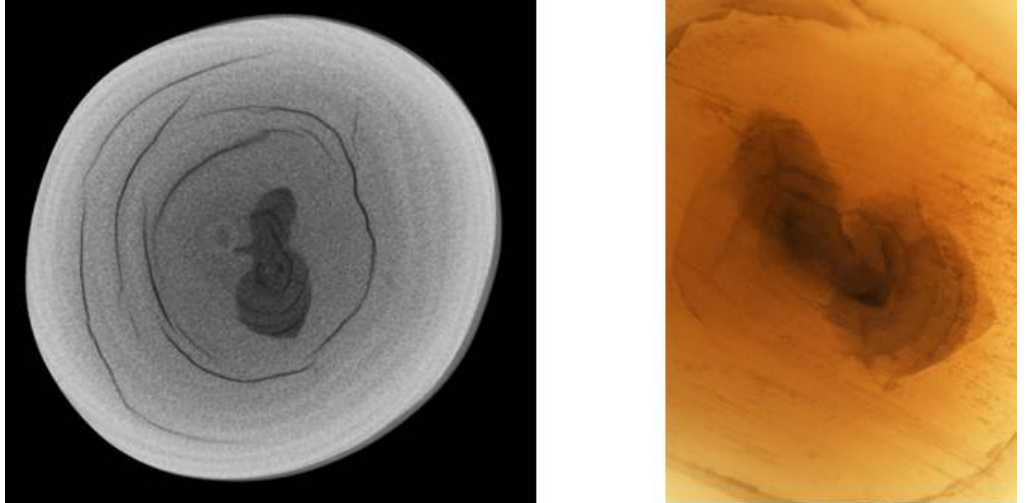
Figure 33. The vaterite growth sector presented in the maps corresponds to the pearl’s internal structure, obtained from X-ray computed microtomography analysis (µ-CT, left ) and observed in photomicrograph with transmitted light ( right ). The vaterite showed lower radiodensity (more transparent) to X-ray than the aragonite area, and it appeared as a darker gray region in µ-CT image.